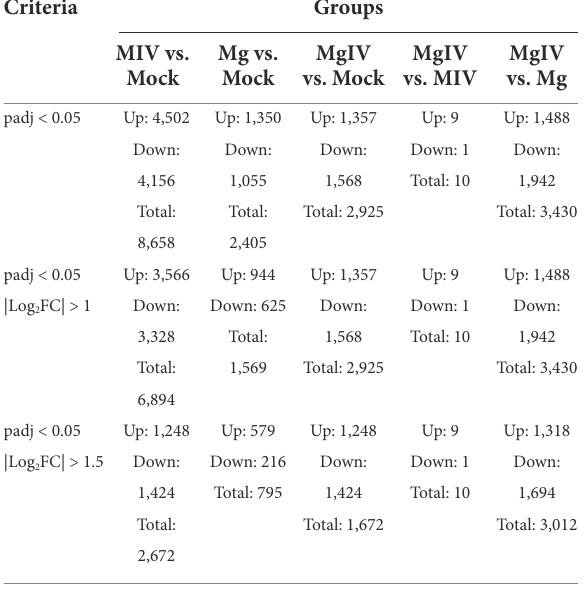
TABLE 3 Number of differentially expressed genes of samples. Criteria